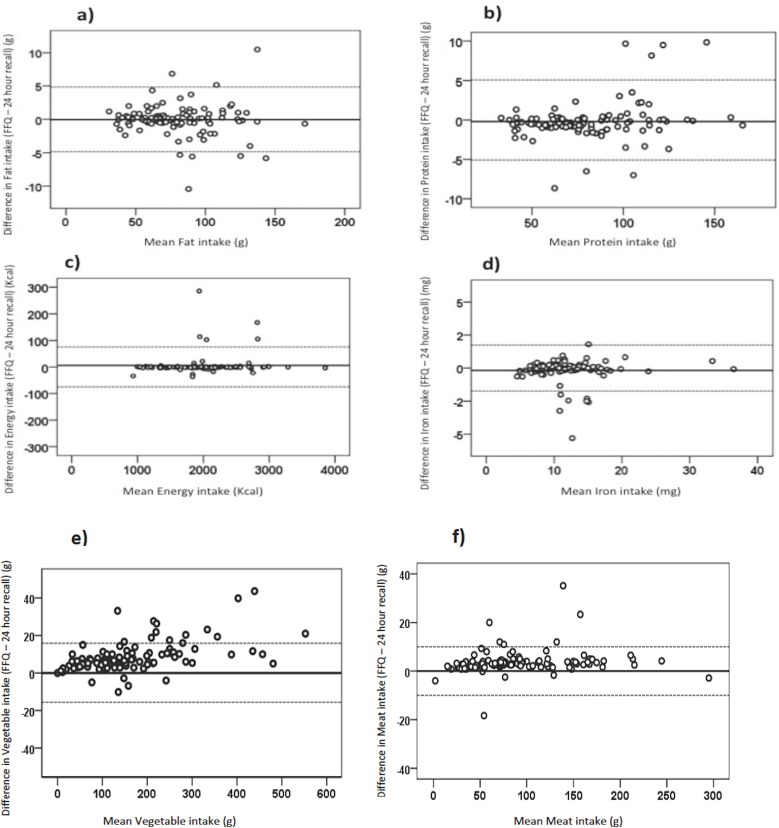
Bland-Altman plot representing the agreement between the average of nutrient intakes measured from the FFQ and the 24f DRs.The solid line represents the average difference between the two methods used (FFQ and 24h DRs), while the dashed line represents the distance between the limits of agreement (± 2SD). (a) Bland-Altman analysis for fat intake; (b) Bland-Altman analysis for protein intake; (c) Bland-Altman analysis for energy intake; (d) Bland-Altman analysis for iron intake; (e) Bland-Altman analysis for vegetable intake; (f) Bland-Altman analysis for meat intake.